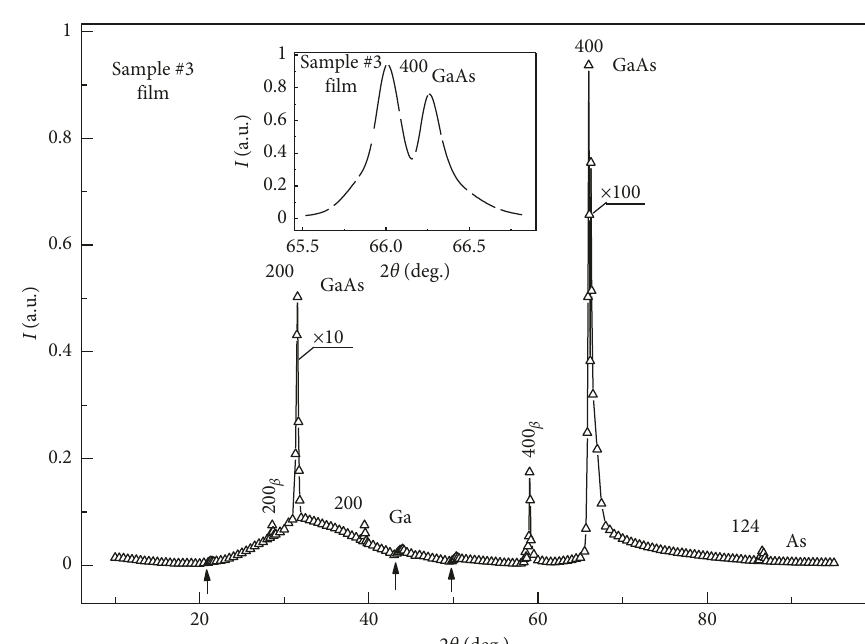
Figure 6: X-ray diffraction pattern of epitaxial film of solid solution (GaAs)